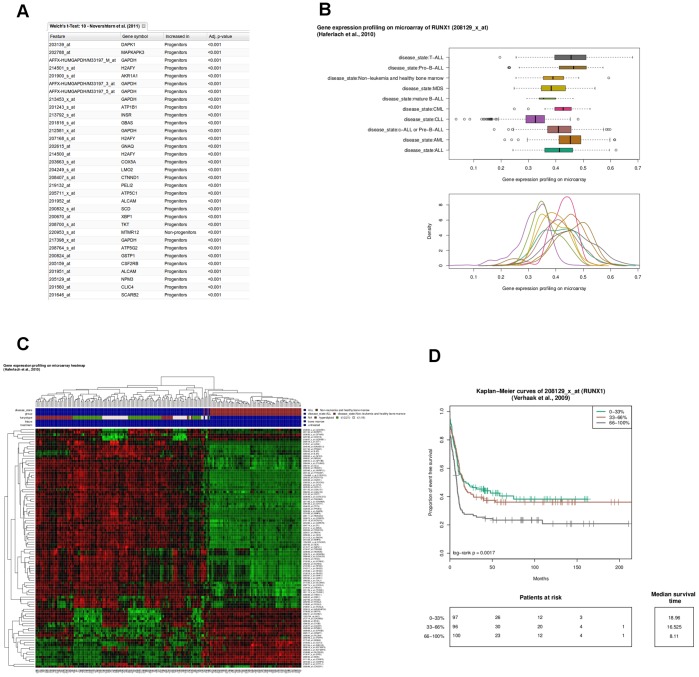
The role of RUNX1 and its binding sites in leukemias.(A) Screenshot of a t-test result table with the 33 most differentially expressed genes with RUNX1 binding sites in progenitor and non-progenitor cells. (B) Distribution of RUNX1 expression for different leukemic disease states. (C) Heat map and hierarchical clustering of patients with acute lymphoblastic leukemia and non-leukemia samples with healthy bone marrows for gene expression of genes with RUNX1 binding sites and highest variances over all samples. The phenotype color grid at the top represents the sample characteristics. (D) Kaplan Meier curves of event-free survival for patients with acute myeloid leukemia with low (≤33% quantile), median (>33% quantile and ≤66% quantile), and high RUNX1 expression (>66% quantile).